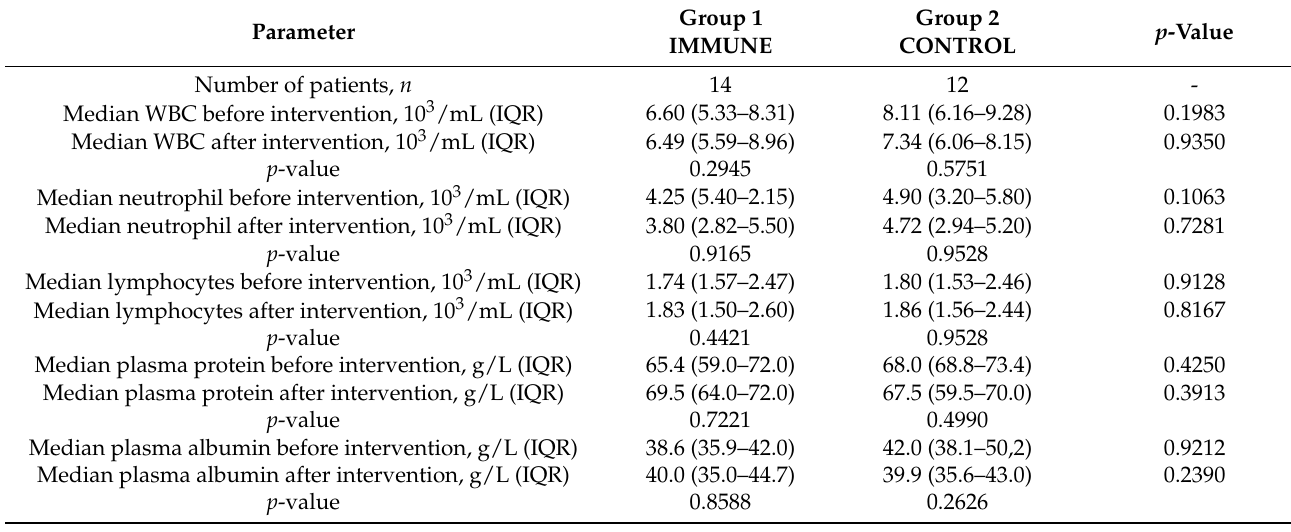
Table 2. Blood parameters.